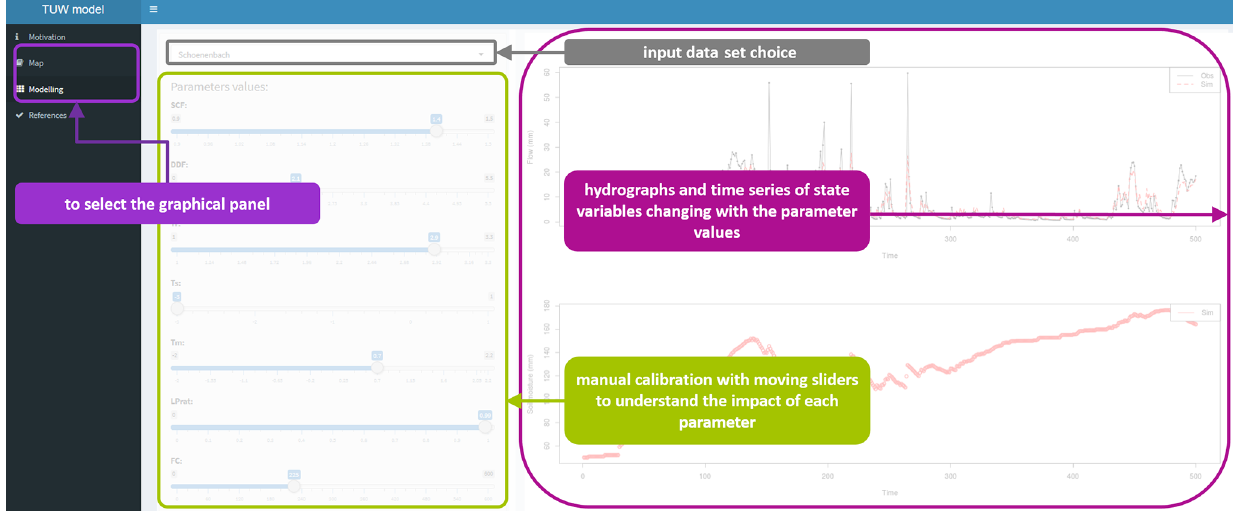
Figure B3. Graphical user interface of the TUWmodel package, with a diagram describing the different functionalities.